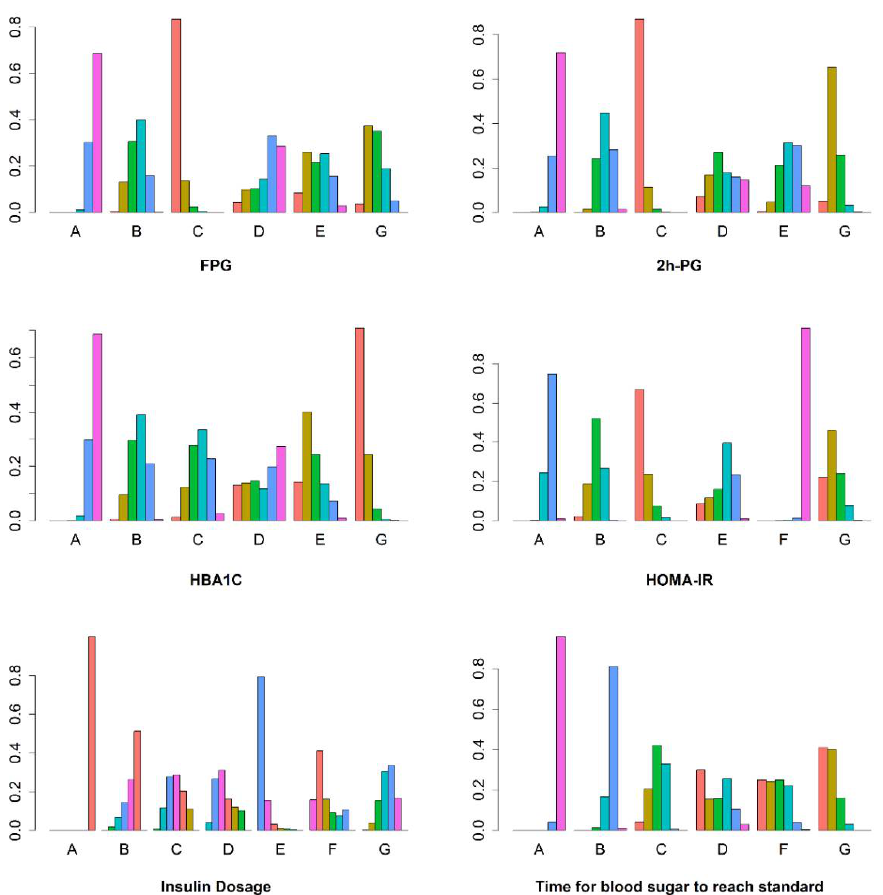
Figure 6. Ranking chart of meta-analyses of different interventions and outcomes. Treatments of the various groups: A: “CSII”, B: “CSII + TZDs”, C: “CSII + Metformin/MF”, D: “CSII + AGIs”, E: “CSII + GLP-1Ras”, F: “CSII + SGLT2is”, and G: “CSII + DPP-4is”.